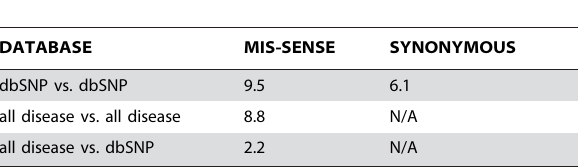
Table 2. ODDs ratios for disease-gene variant